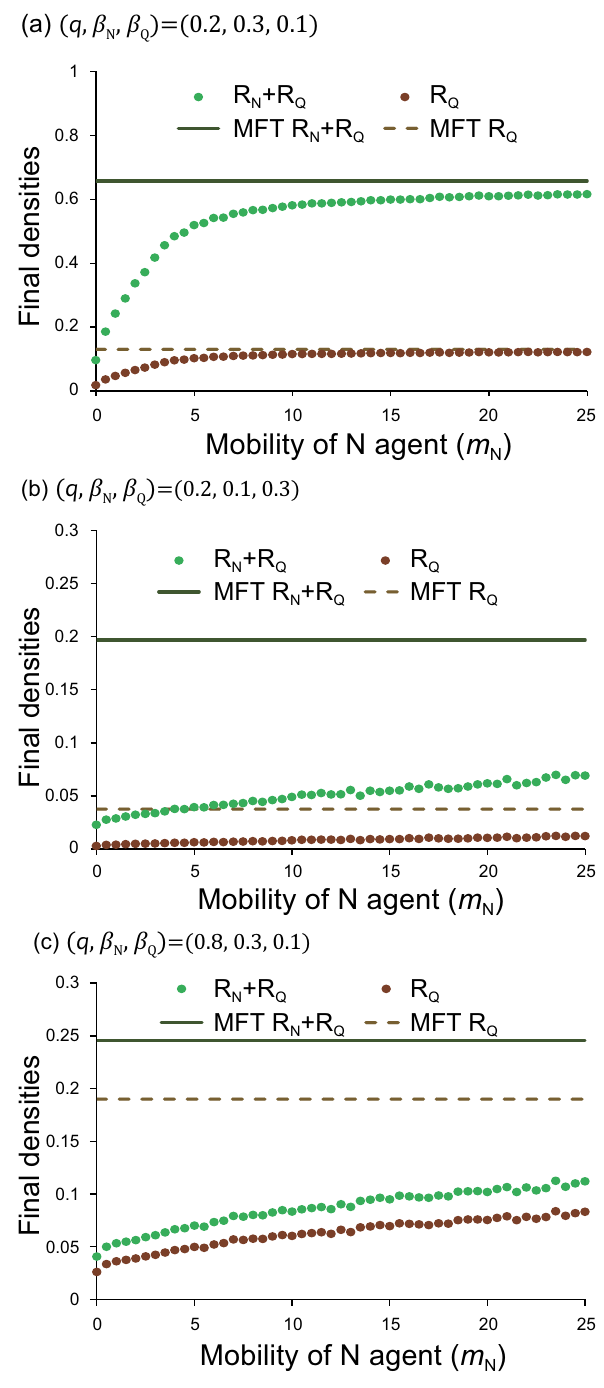
Figure 4. Serious effect of non-quarantined agents (N). Both [ R N ( ∞ ) + R Q ( ∞ ) ] and R Q ( ∞ ) are plotted against m N . Uninfected agent (S) can move with m S = 2 . The horizontal axis means the migration rate ( m N ) of N, where both N and R N move with the same rate. In contrast, the other agents (Q and R Q ) never move: m k = 0 for k = Q, R Q